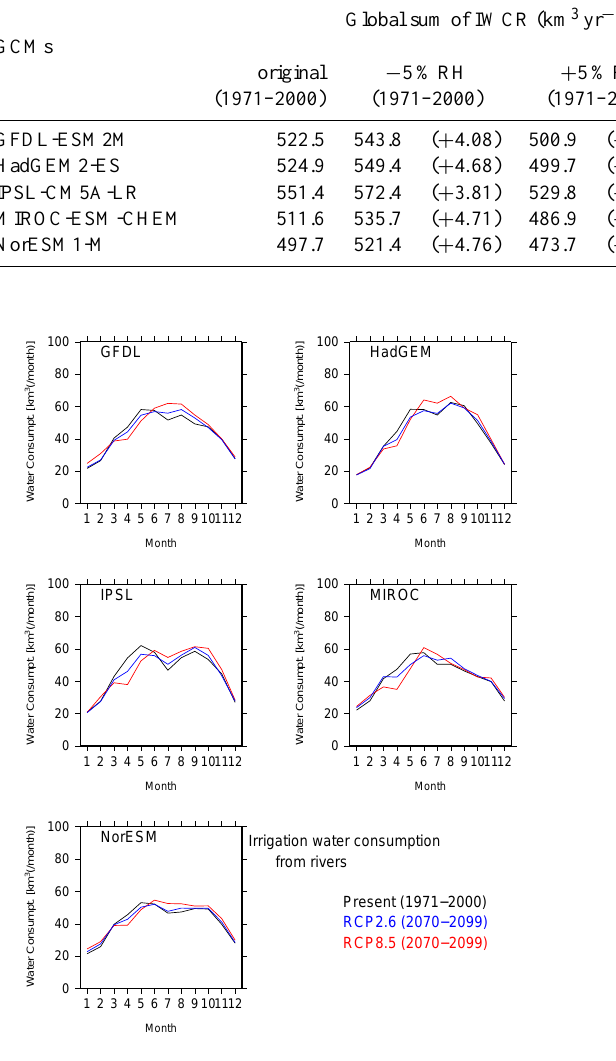
tom line), in comparison with those in Table 4, are reduced from 282.9 to 167.0 km 3 yr − 1 and from 53.7 to 40.1 km 3 yr − 1 for the present IWD and IWCR, respectively. Similarly, the range decreases from 381.1 to 214.8 km 3 yr − 1 and from